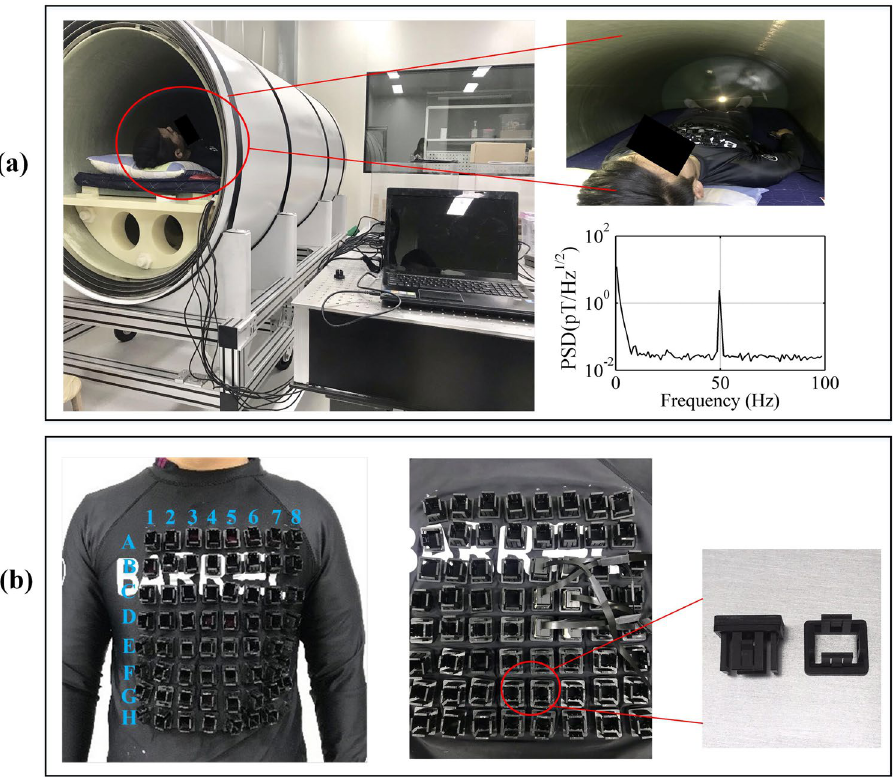
Figure 1. ( a ) From left to right is the magnetically shielded cylinder and magnetic noise spectrum diagram when the shielded cylinder is closed. The magnetic shield is closed during the process of acquiring the MCG signal. ( b ) Position labels of the 8 × 8 array with 30 mm intervals, QZFM magnetometer and customized